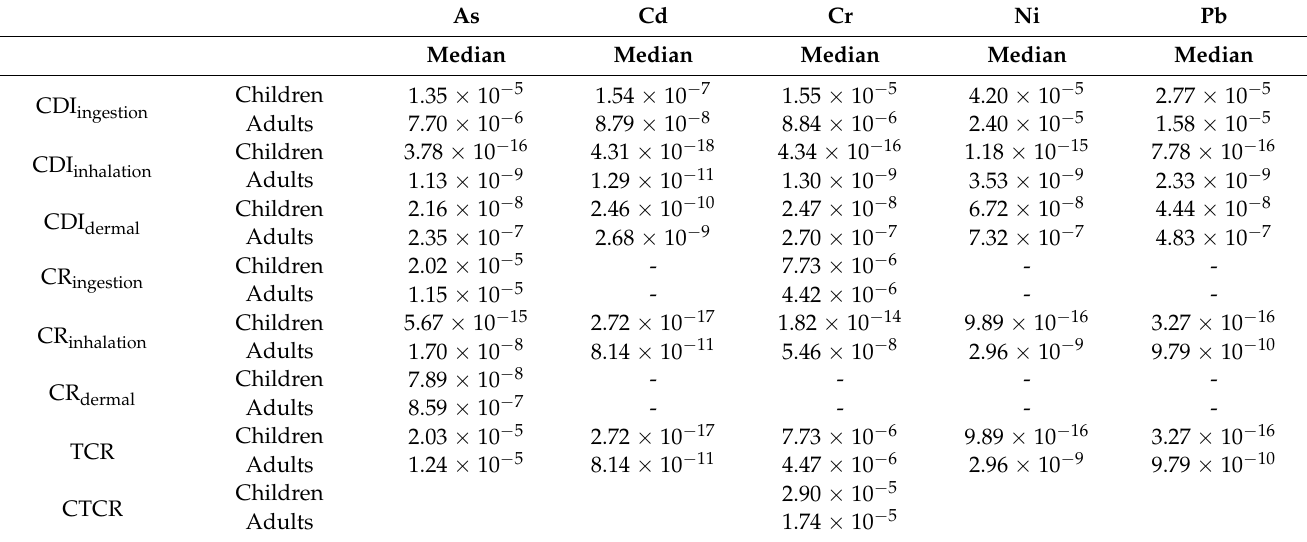
Table 8. Median values of carcinogenic risk indictors to humans from soil